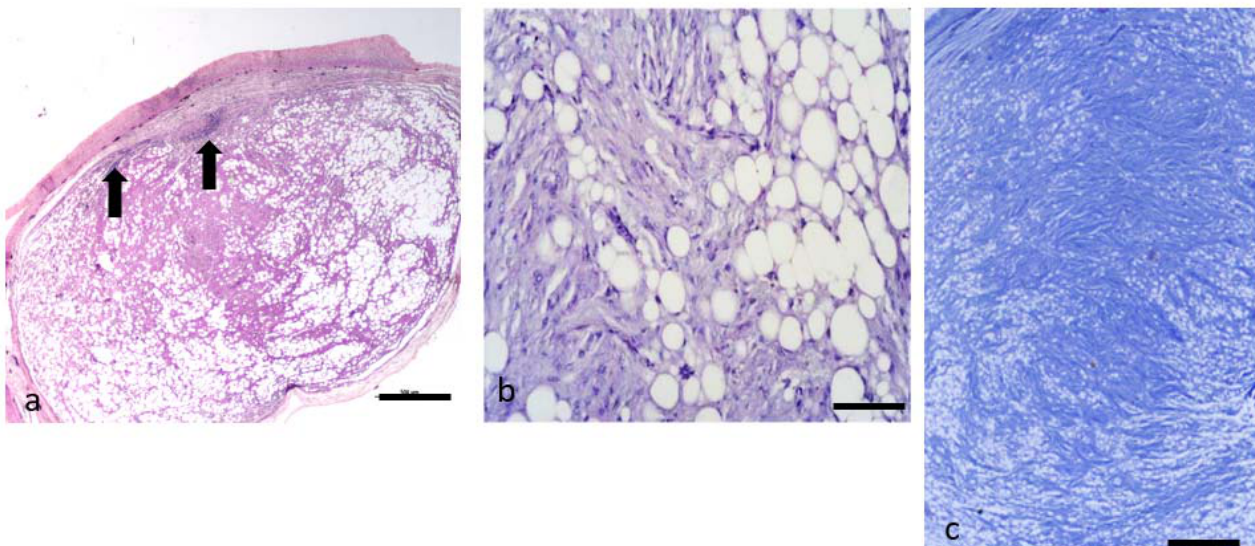
Figure 3. ( a – c ). FIBROLIPOMA. ( a – c ). Histological section of a fibrolipoma. ( a ) shows the prevalence of fibroblasts